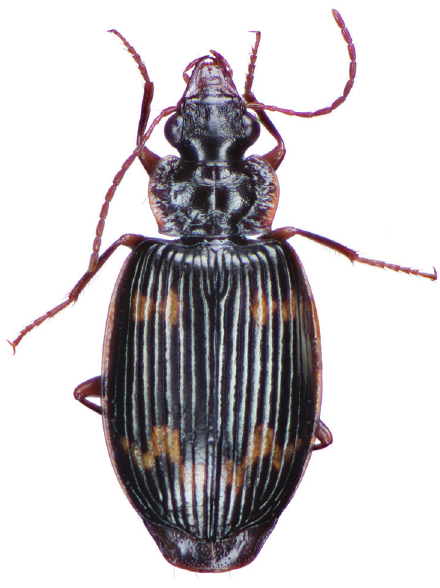
Figure 52. Dorsal habitus and color pattern of C. ( Coptoderina ) proksi Jedlička. (OBL 6.98 mm).